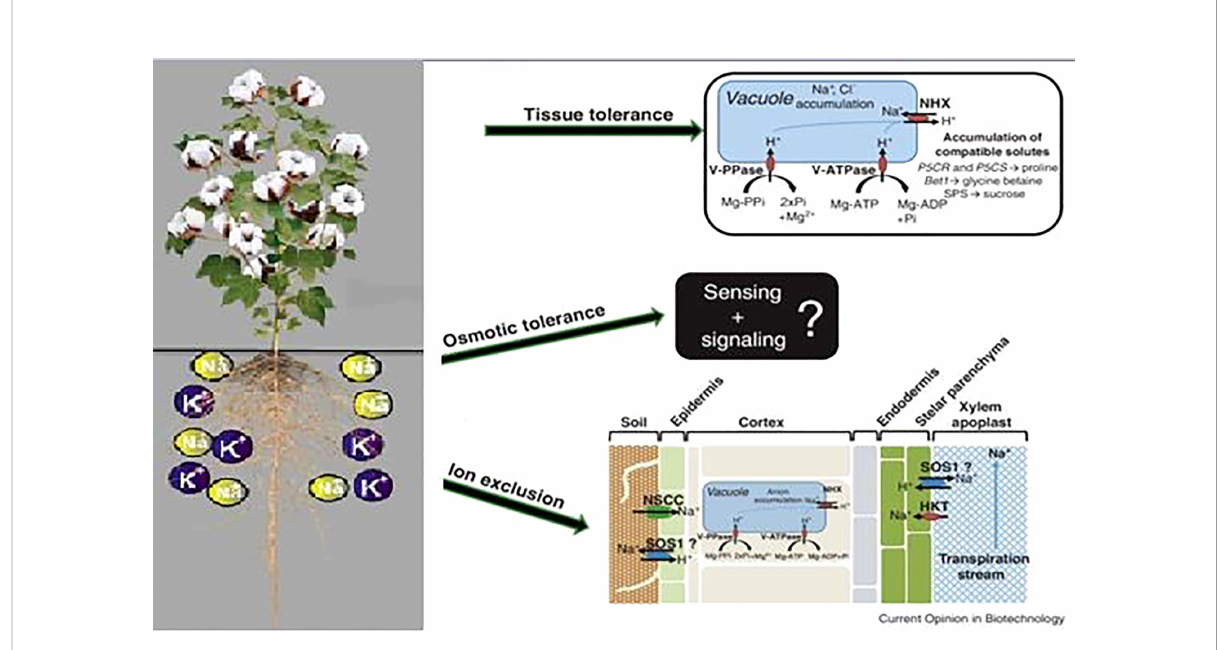
FIGURE 2 Mechanisms of tissue tolerance, osmotic tolerance and ion exclusion in a plant (Roy,